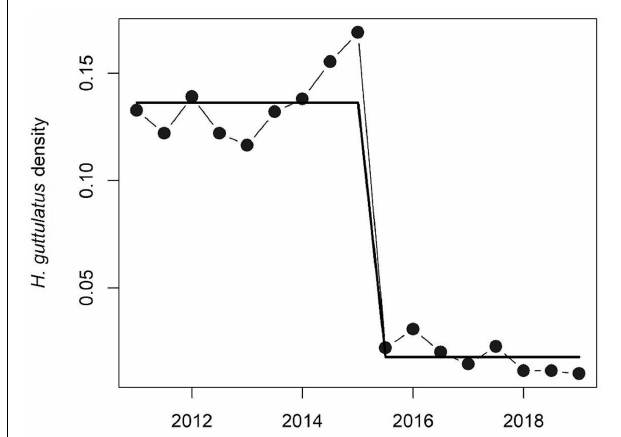
FIGURE 4 | Breakpoint analysis of H. guttulatus density. Solid lines indicate fitted values from breakpoint analysis. Model details are reported in Table 2 .